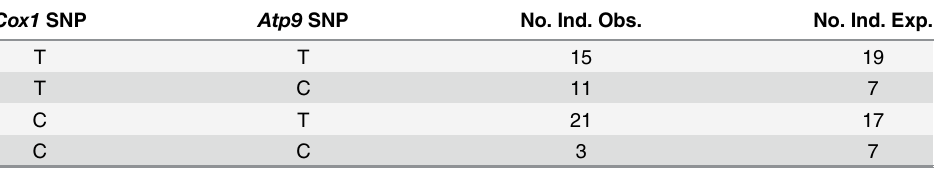
Table 4. Observation of the four-gamete rule and observed and expected two-locus nucleotide combinations. Cox1 SNP Atp9 SNP No. Ind. Obs. No. Ind. Exp. T T 15 19 T C 11 7 C T 21 17 C C 3 7 No. Ind. Obs. = number of individuals observed and No. Ind. Exp. = number of individuals expected when D ’ = 0.